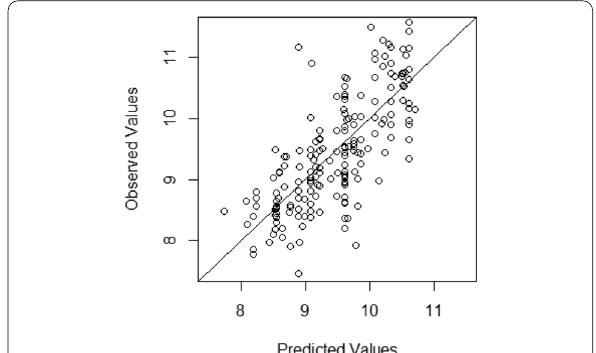
Fig. 7 Scatter plot of predicted and observed values of Analysis 2 (Yamaha). The unit of the axes is the logarithm of winning bid price